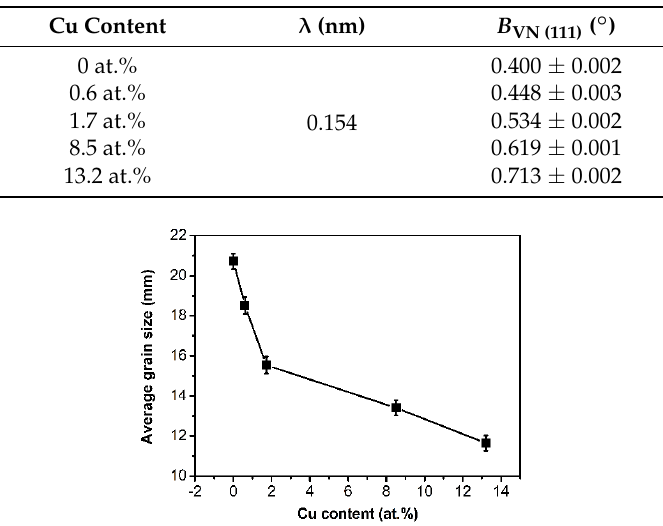
Figure 5. Grain sizes of VCN–Cu composite films with different Cu contents.